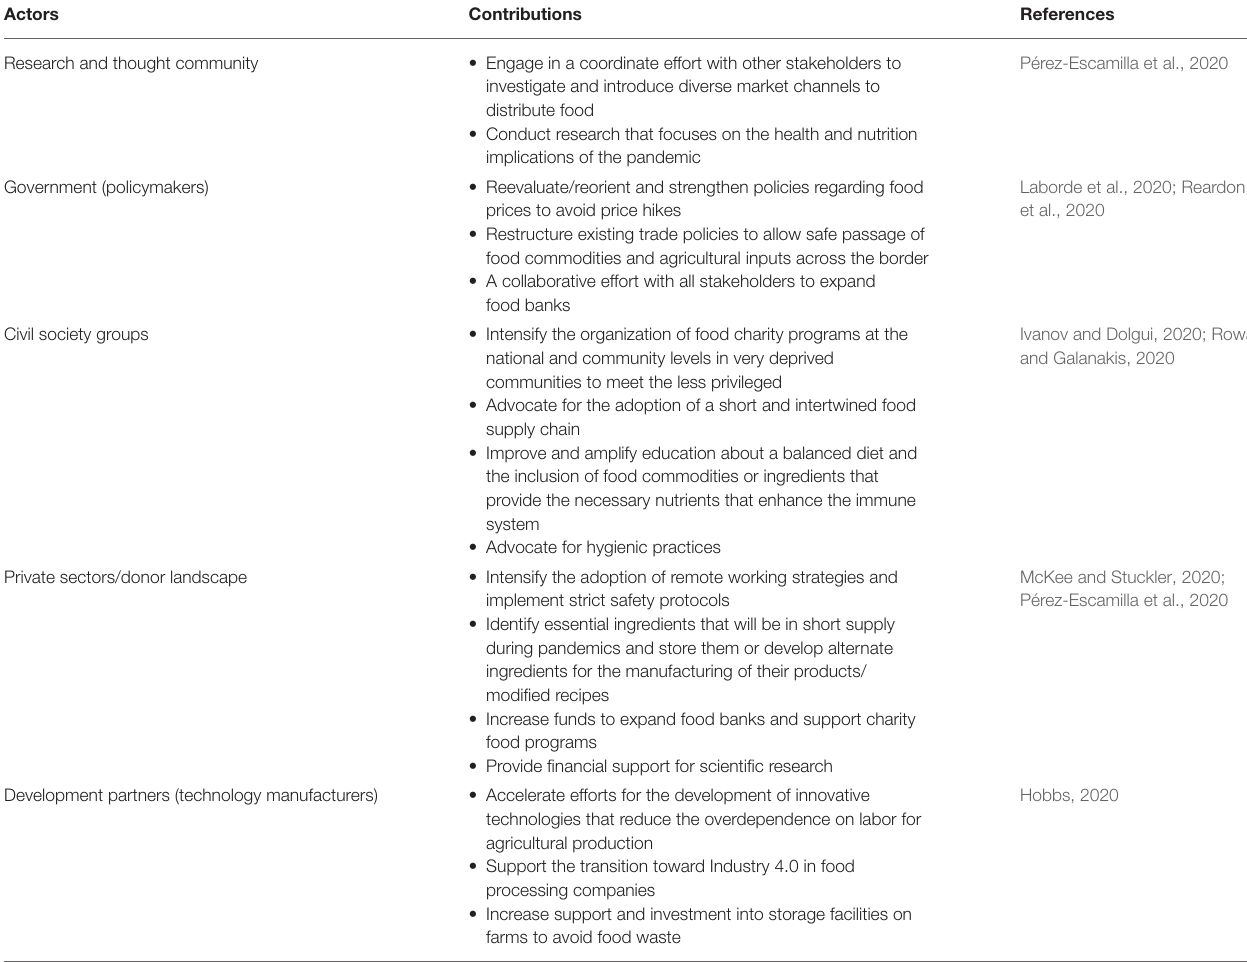
TABLE 10 | Redesign of the contributions of key actors in building a resilient food system against COVID-19.